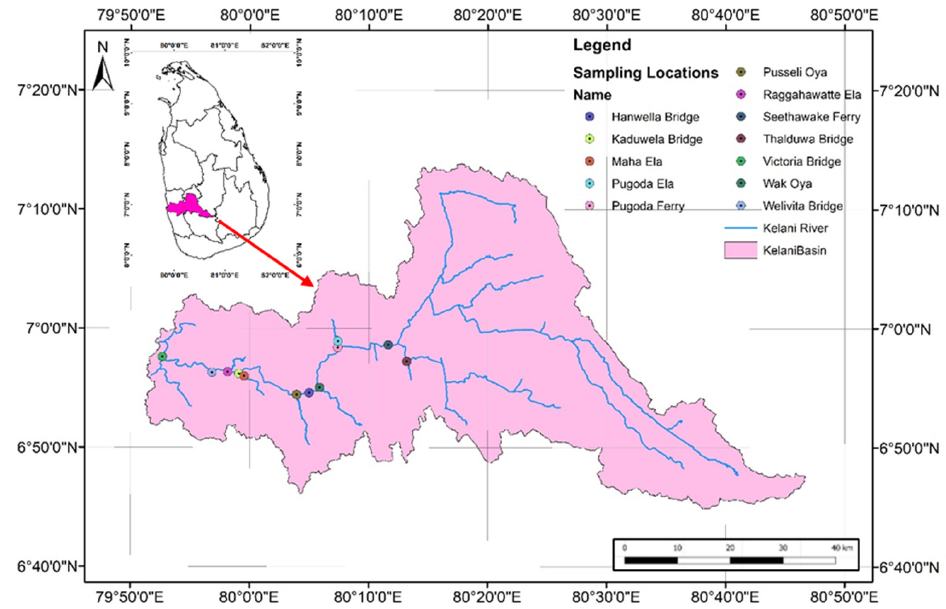
Figure 2. Sampling locations along the Kelani River basin.